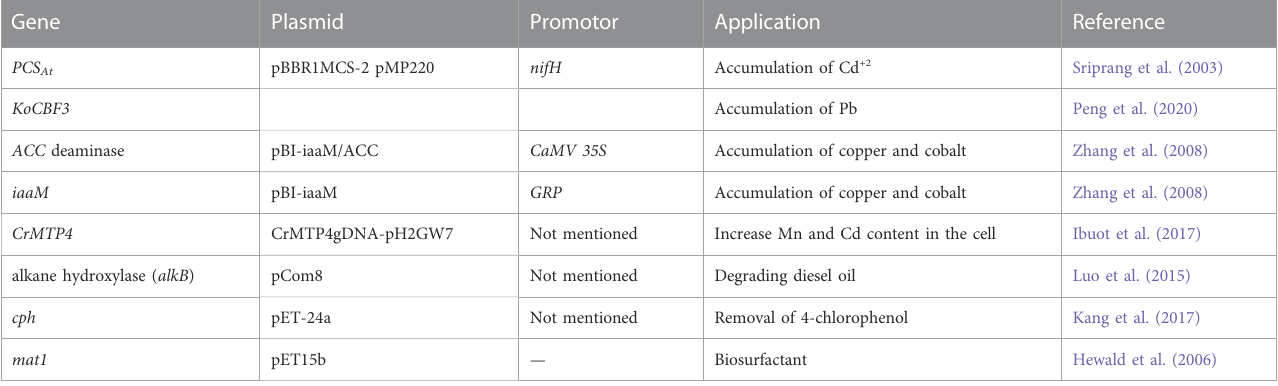
TABLE 2 Candidate genes for heavy metal tolerance and accumulation and hydrocarbon